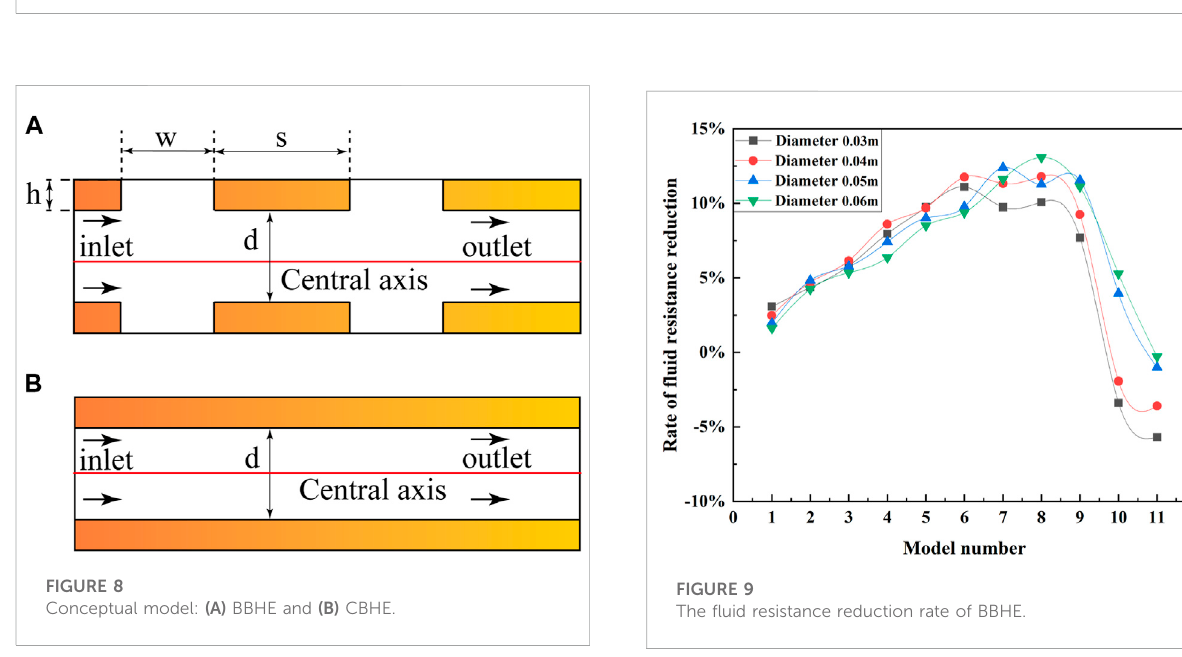
FIGURE 8 Conceptual model: (A) BBHE and (B) CBHE.